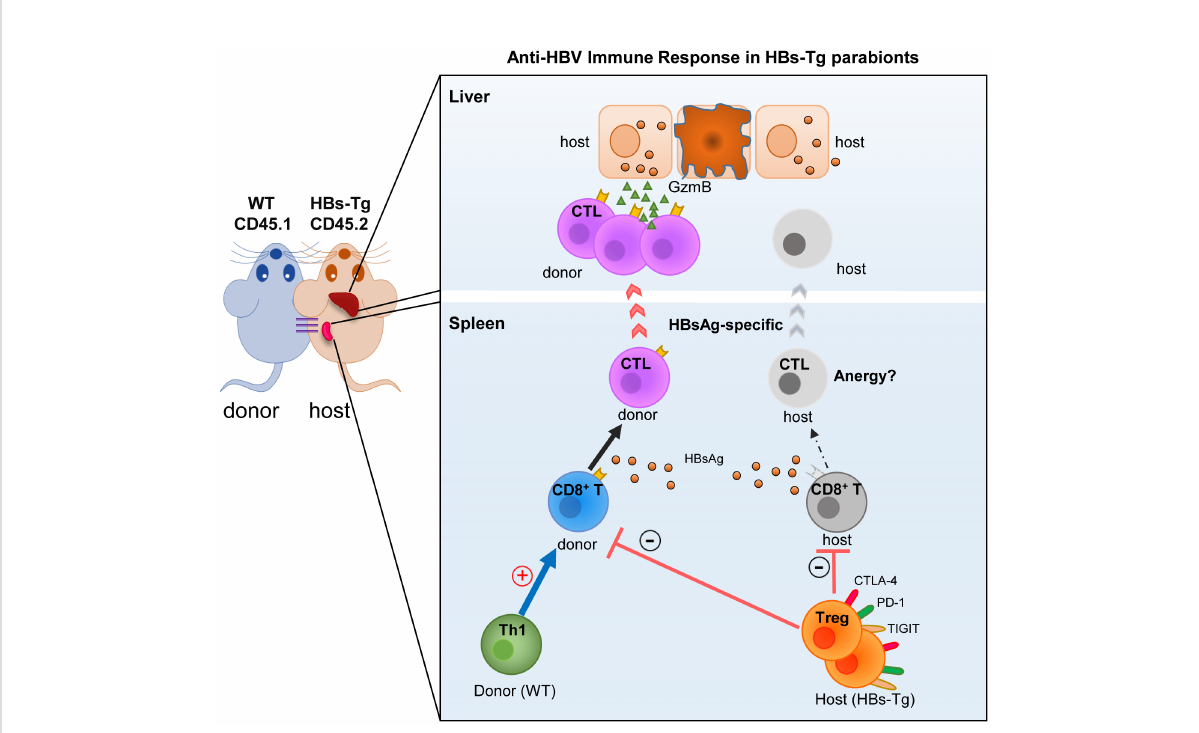
FIGURE 10 Mechanisms of HBV immune tolerance in HBs-Tg parabionts. By using the WT-HBs-Tg parabiotic mouse model, the major mechanisms underlying the immune tolerance of HBV persistence were elucidated, including the incompetent anti-HBV CD8 + T cells and insuf fi cient help from CD4 + T cells in HBs-Tg